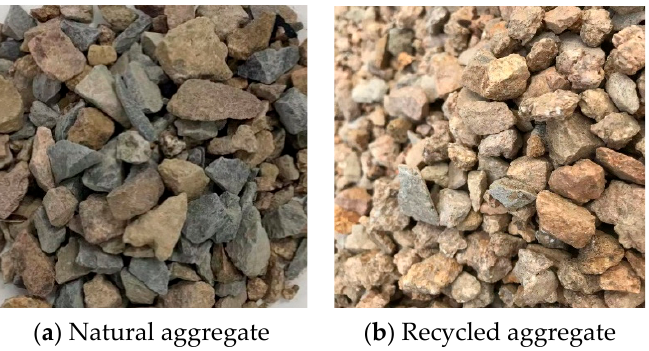
Table 4. Composition of recycled aggregate.